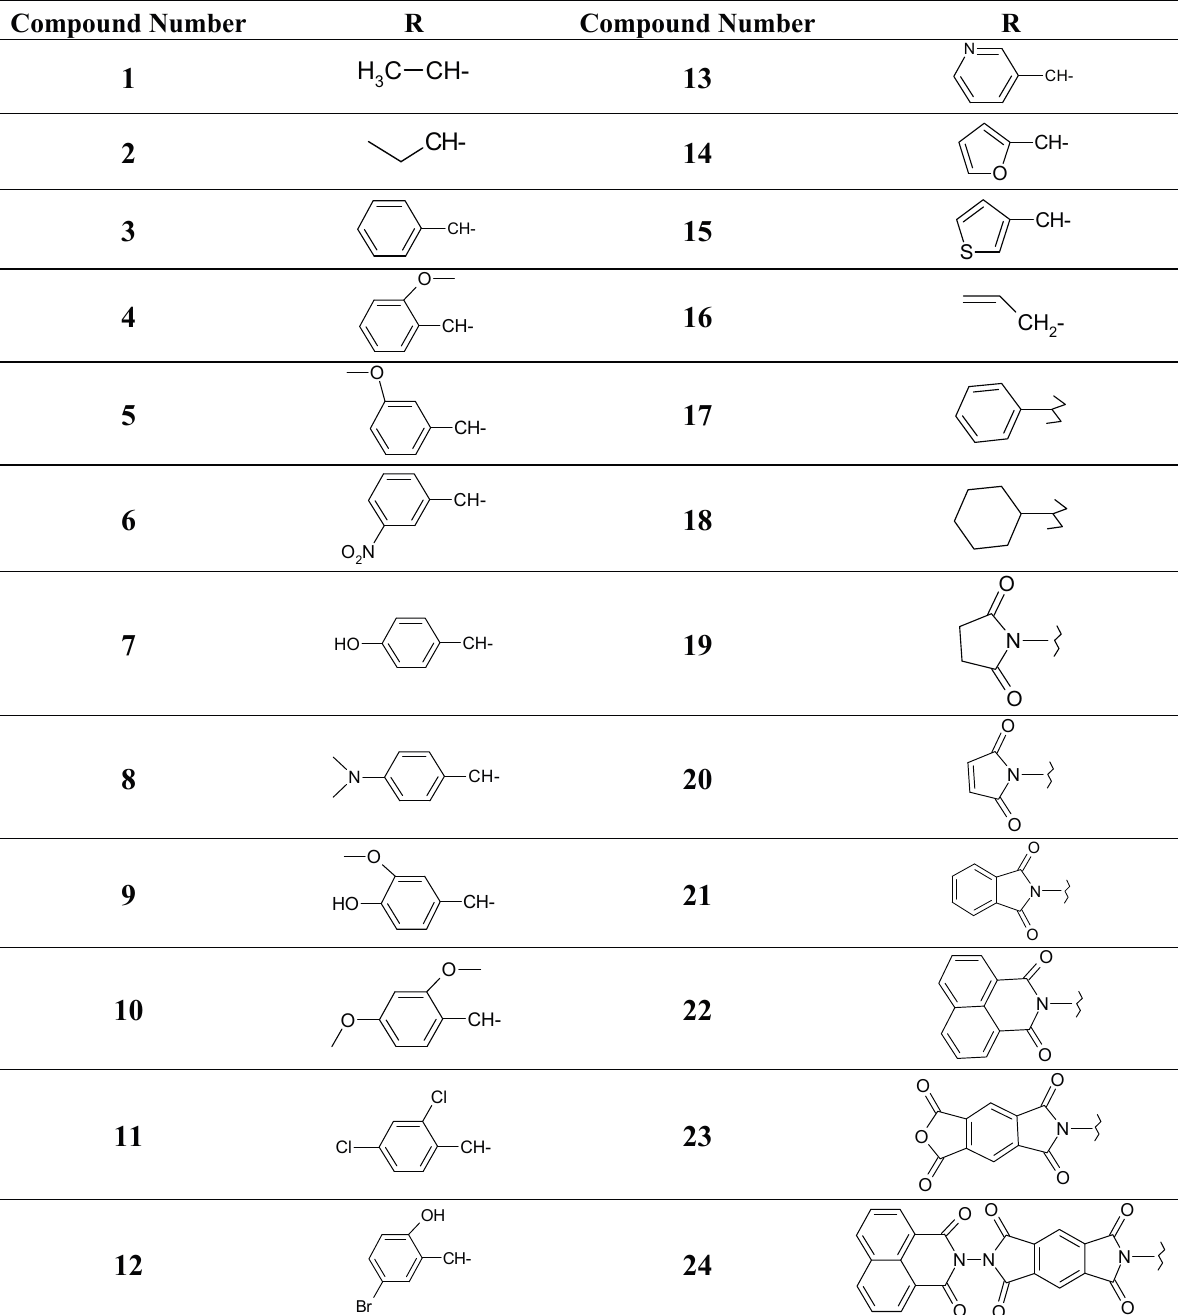
Table 1. Synthesized 2-amino-benzo[de]isoquinolin-1,3-dione derivatives ( 1 – 24 ). Compound